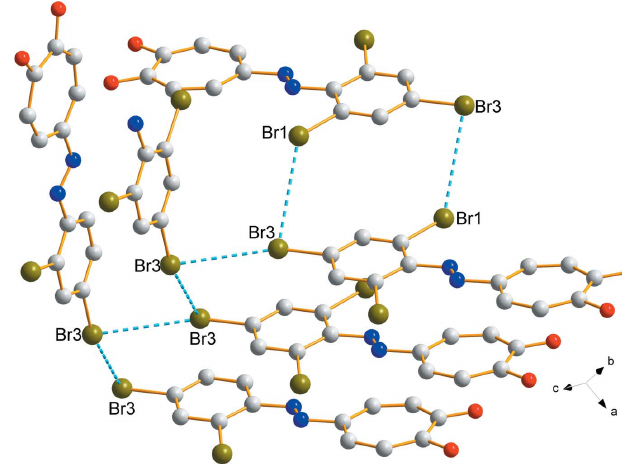
Figure 3 The Br (cid:2)(cid:2)(cid:2) Br interactions of I illustrated with dashed bonds. Hydrogen atoms omitted for clarity.